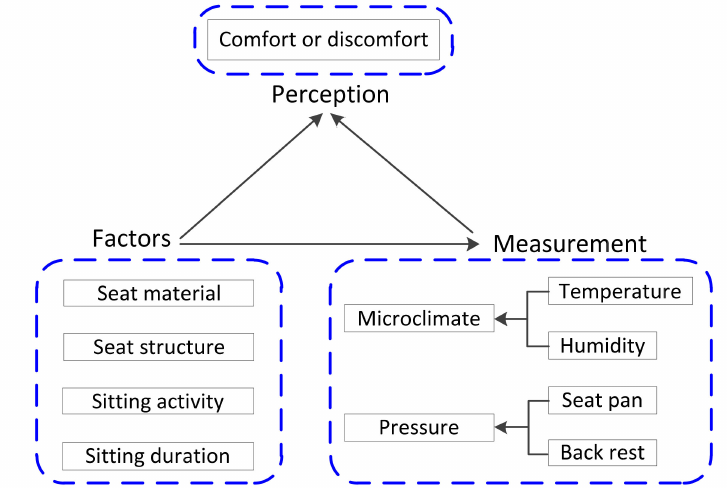
Figure 1. Relationship between objective measurements of microenvironmental changes at the body–seat interface and the characteristics of seats (material and structure) and human (sitting activities and sitting duration). The characteristic factors influence subjective perception of sitting comfort or discomfort and can be measured with the help of electronic